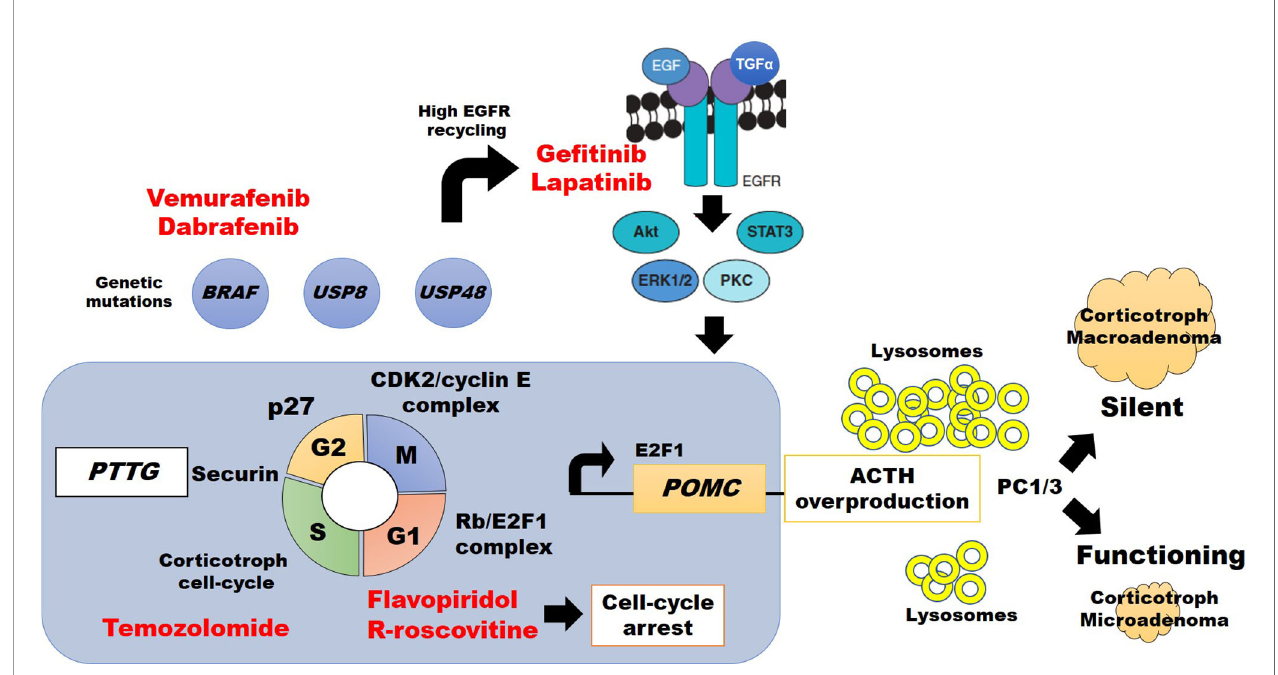
FIGURE 1 | Abdnomal regulation of cell cycle division, ACTH synthesis, and potential therapeutic approach (highlighted in red) in silent vs. clinically active corticotroph tumors (see text for